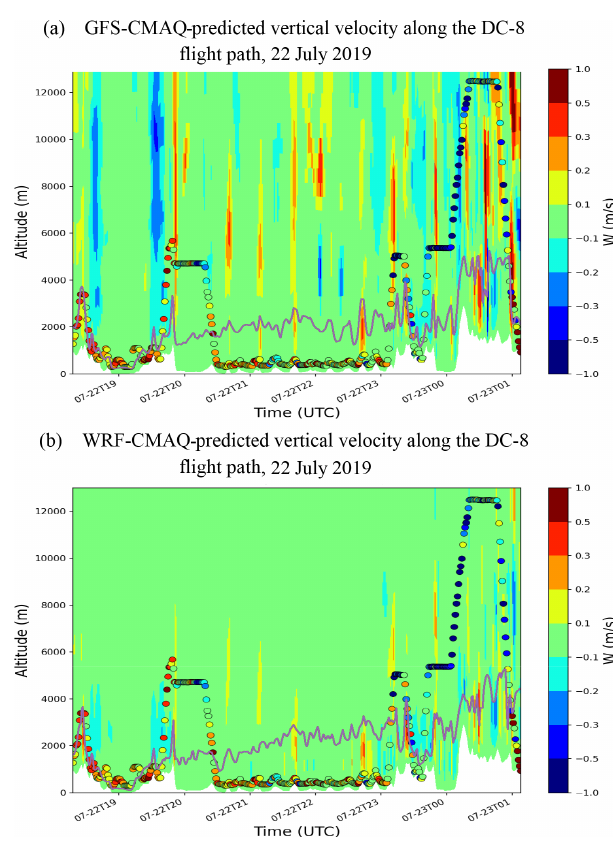
Figure 8. Curtain plots of the vertical velocity ( W ) predicted by GFS-CMAQ (a) and WRF-CMAQ (b) along the DC-8 flight on 22 July 2019. The colored dots show the DC-8-measured vertical velocities, and the solid lines show the predicted PBL heights of these two